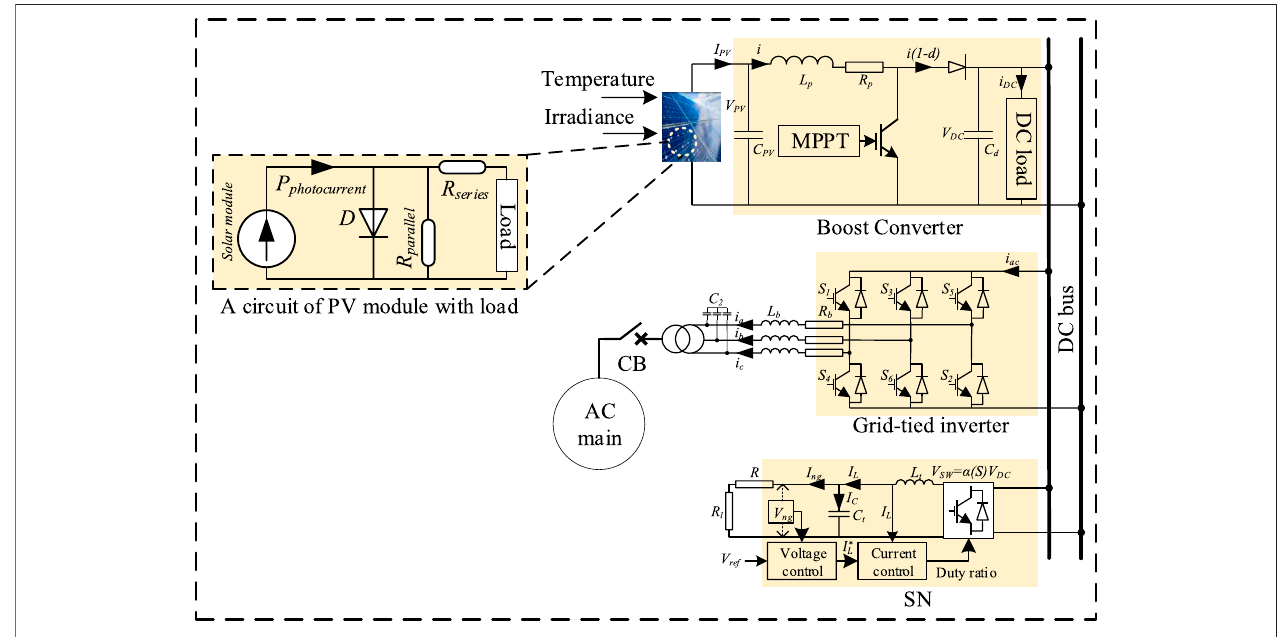
FIGURE 1 | A basic circuit diagram of the proposed hybrid source of AC-DC MG